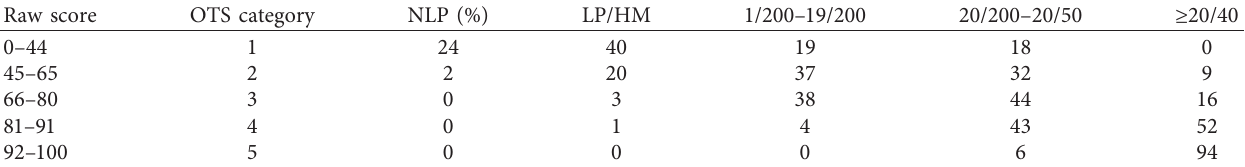
Table 3: The percentage of the final visual acuity based on the OTS in mechanical